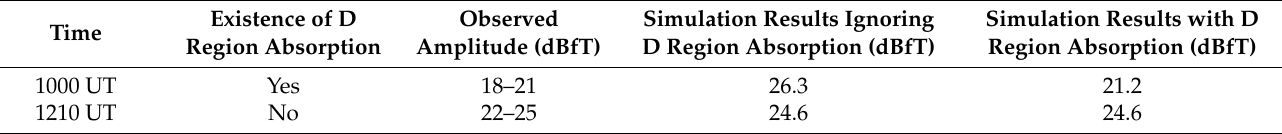
Table 1. Comparison of simulation results with experimental